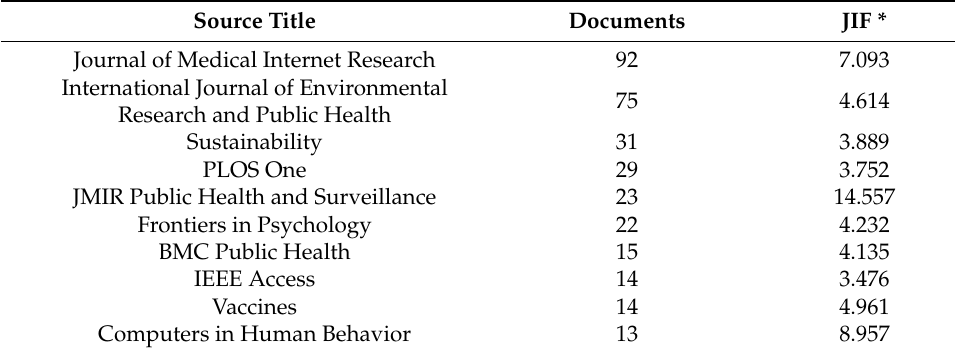
Table 3. Top 10 productive